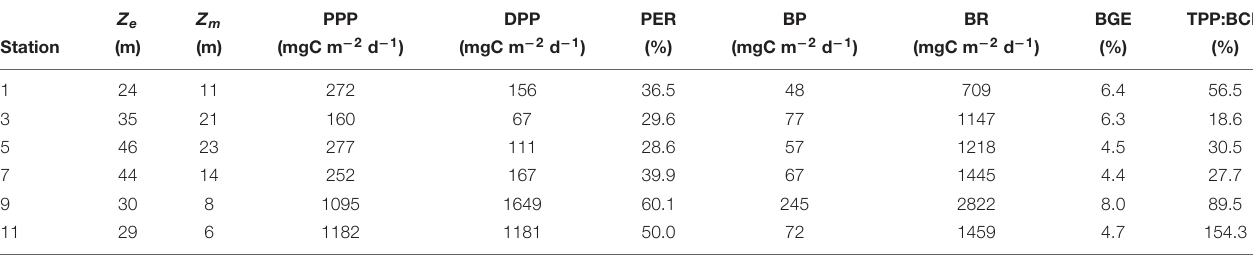
TABLE 1 | Depth-integrated microbial fluxes of photosynthesized